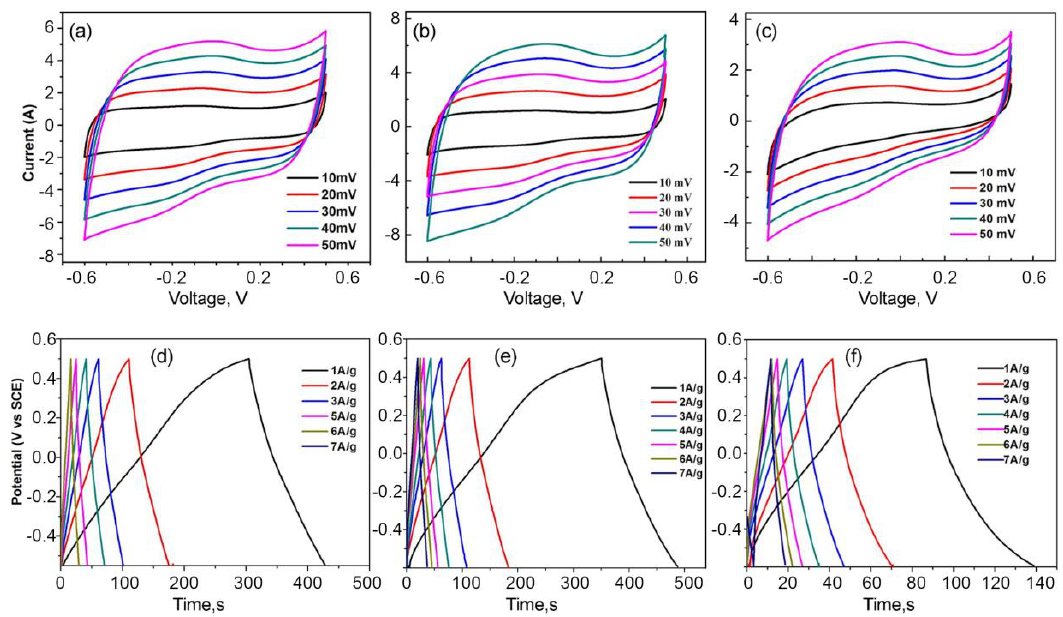
Figure 6. Cyclic voltammetry (CV) plots of the 3D nitrogen self-doped graphene-based carbon aerogel activated at ( a ) 700 °C, ( b ) 800 °C, ( c ) 900 °C. Galvanostatic charge/discharge curves of the 3D nitrogen activated at ( a ) 700 ◦ C, ( b ) 800 ◦ C, ( c ) 900 ◦ C. Galvanostatic charge / discharge curves of the 3D nitrogen self-doped graphene-based carbon aerogel activated at ( d ) 700 °C, ( e ) 800 °C, ( f ) 900 °C. self-doped graphene-based carbon aerogel activated at ( d ) 700 ◦ C, ( e ) 800 ◦ C, ( f ) 900 ◦